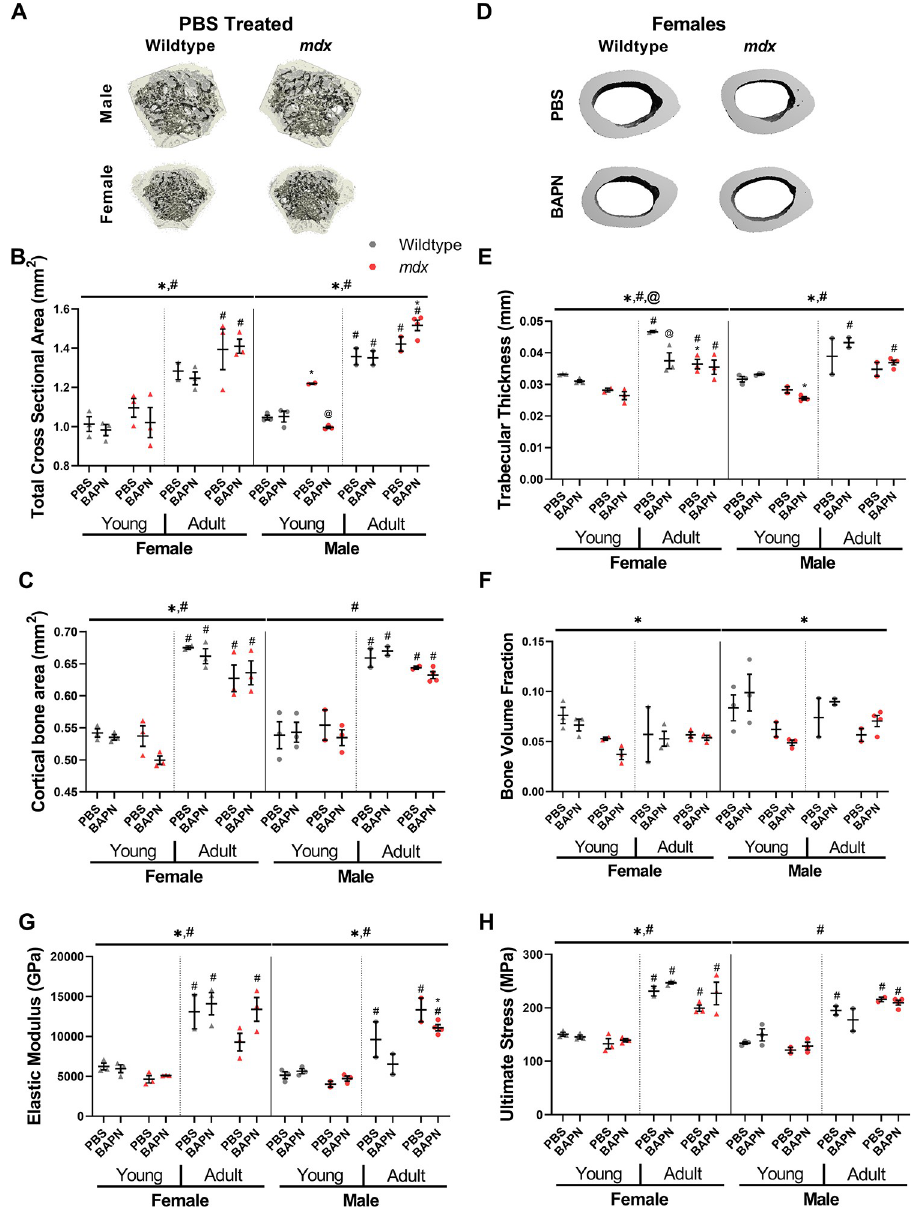
Fig 6. Microstructual and mechanical properties of long bones. (A) Representative images of mid-diaphyseal total cross-sectional area of the femur by μ CT. (B) Total cross-sectional area was significantly increased in adult and mdx mice. (C) Cortical bone area was significantly increased in both male and female mice, and female mice also showed decreased area in mdx mice. (D) Representative images of cortical bone area. (E) There was an increase in trabecular thickness in adult mice, and a decrease in mdx mice. BAPN also decreased thickness in adult female wildtype mice. (F) Trabecular bone volume fraction was decreased in mdx mice. (G) Adult mice had significantly increased elastic modulus. (H) Adult mice had significantly increased ultimate stress. Significance by genotype: � p < 0.05, age: #p < 0.05, and treatment: @p < 0.05 determined by three-way ANOVA test with post-hoc Sidak multiple comparisons